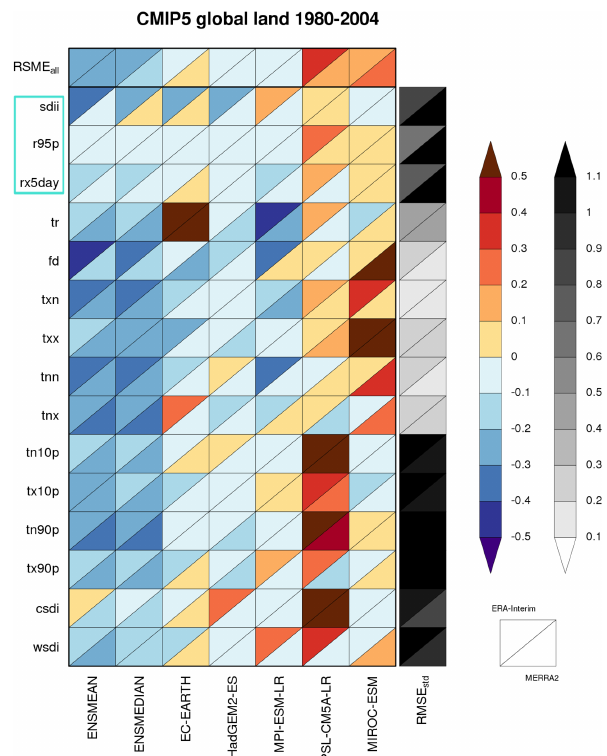
Figure 7. “Portrait” diagram showing relative spatially averaged root mean square error (RMSE) in the 1980–2004 climatologies of 12 temperature and 3 precipitation indices (marked with a blue rectangle) simulated by CMIP5 models (5 in this example along the x axis) with respect to the two reanalyses ERA-Interim (upper triangle) and MERRA-2 (lower triangle). The RMSEs are spatially averaged over all land grid points. The top row (RMSE all ) indicates the mean relative RMSE across all indices for the CMIP5 ensemble mean (first column) and median (second column) as well as each model individually. Blue (red) indicates that a model performs bet- ter (worse) than the median of all model results when compared to the respective reanalysis dataset. The grey shaded column at the right-hand side indicates the median RMSE normalized by the spa- tial standard deviation of the index climatology in the reanalyses (RMSE std ). The root mean square error is shown in greyscale on the right. See Sillmann et al. (2013a) for details. Similar to Fig. 9.37a of the IPCC AR5 report (Flato et al., 2013) and produced with recipe_extreme_events.yml ; for details see Sect.